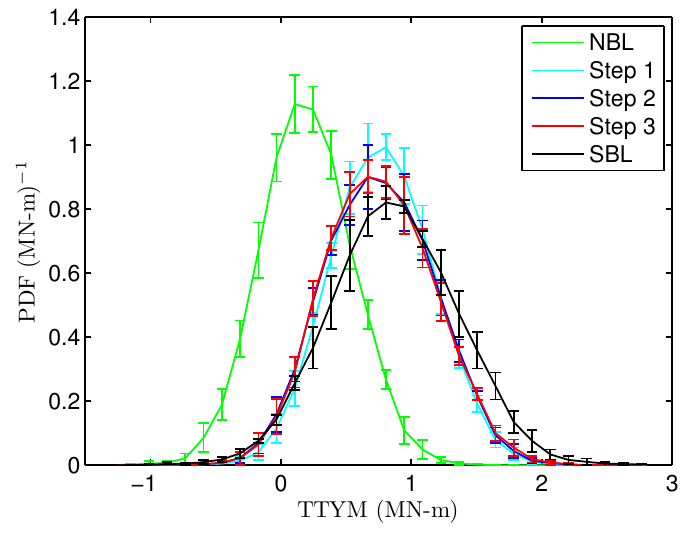
Figure 22. Probability density functions for the tower-top yawing moment, TTYM, for a single case (control).